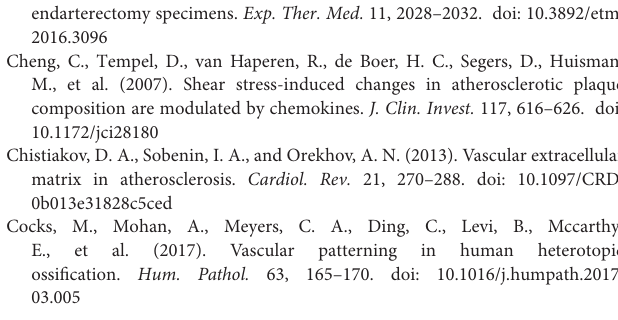
FIGURE S1 | Distribution of carotid bifurcation angle. (A) Total distribution of carotid bifurcation angle in different groups. (B) Distribution of carotid bifurcation angle, internal carotid angle, and laminar shear stress at different heights in both groups. Error bars represent standard error of mean (SEM). TABLE S1 | Logistic regression of demographic and baseline characteristics of the studying